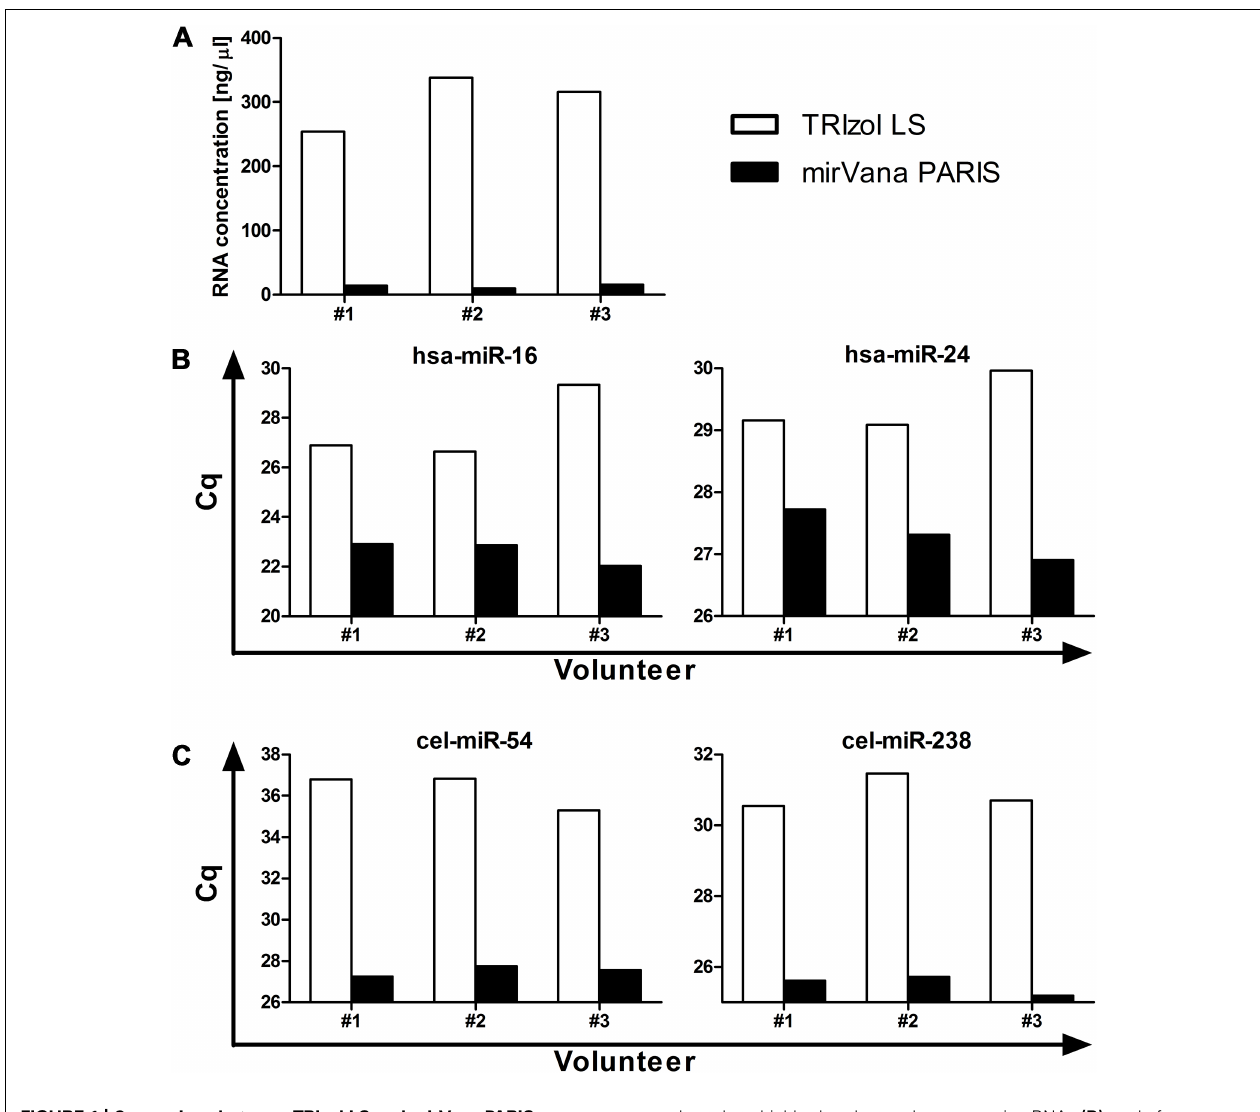
moderately to highly abundant endogenous microRNAs (B) , and of exogenous spike-ins (C) were assessed. RT-qPCR data are presented as raw Cq